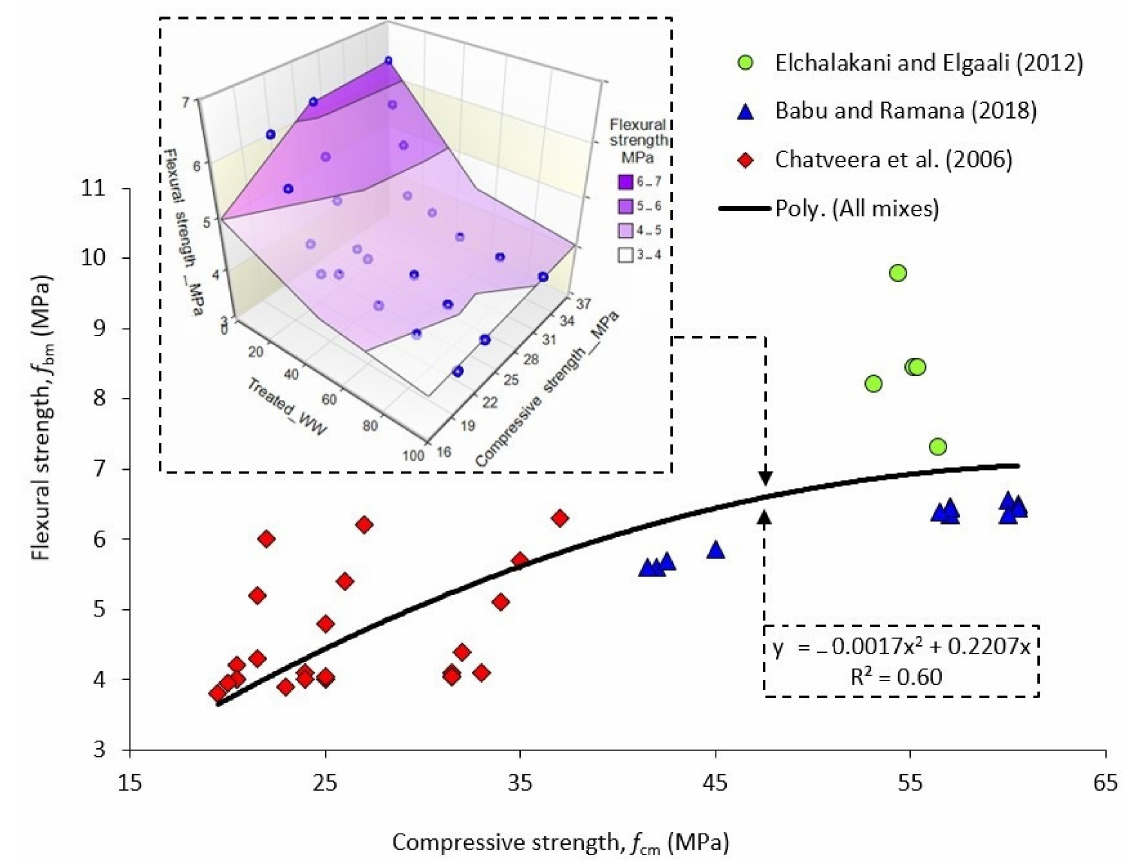
Figure 13. Relationship between compressive strength and flexural strength.